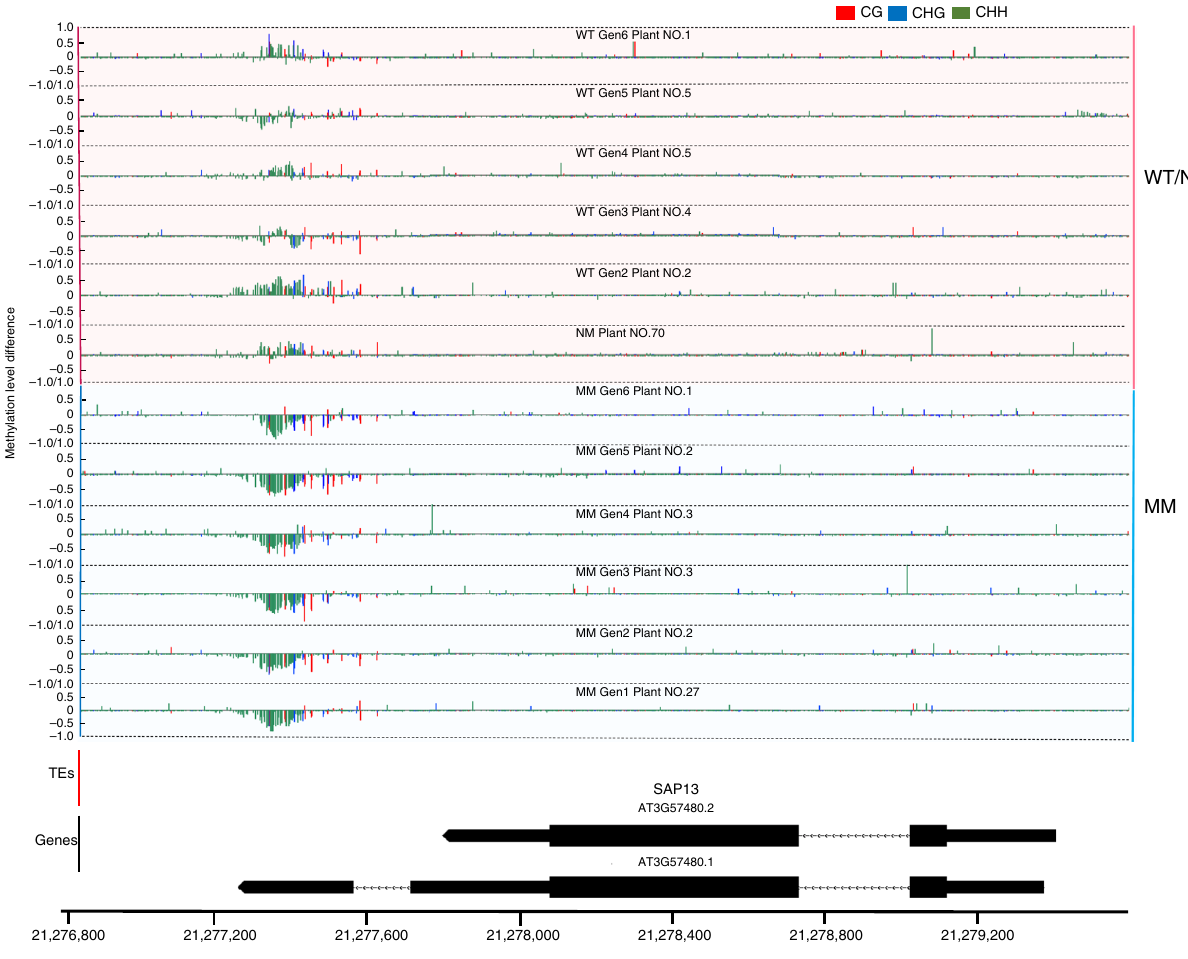
Fig. 7 Methylation changes at DMG loci. Single cytosine methylation level changes in the msh1 memory line (MM) SAP13 (AT3G57480) locus. Methylation level difference at each cytosine is computed by (mC/(mC + uC)) each individual − (mC/(mC + uC) average of all reference plants , with mC denoting methylated cytosine and uC denoting unmethylated cytosine. For gen1, nonmemory plants were used as reference. For gen2 to gen6, wild-type plants were used as the reference for each generation. Only one plant from each generation was selected as representative; the pattern will be slightly different for different individuals due to fl uctuation in methylation. Integrated Genome Browser (version 9.0.2) was used to generate fi